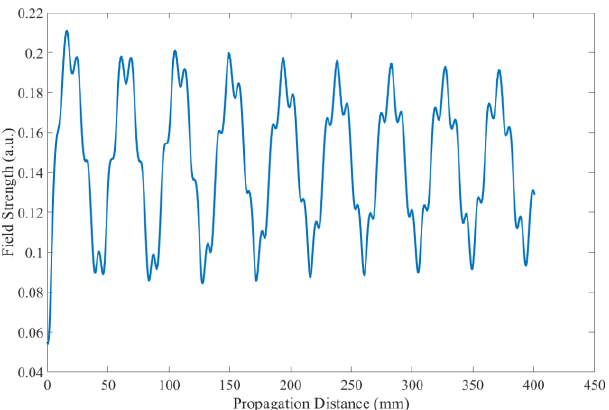
Figure 5. Amplitude of electric field along y axis when the edge length of the losses dielectric bar is 14.4 mm and the incident plane wave is at 10 GHz.